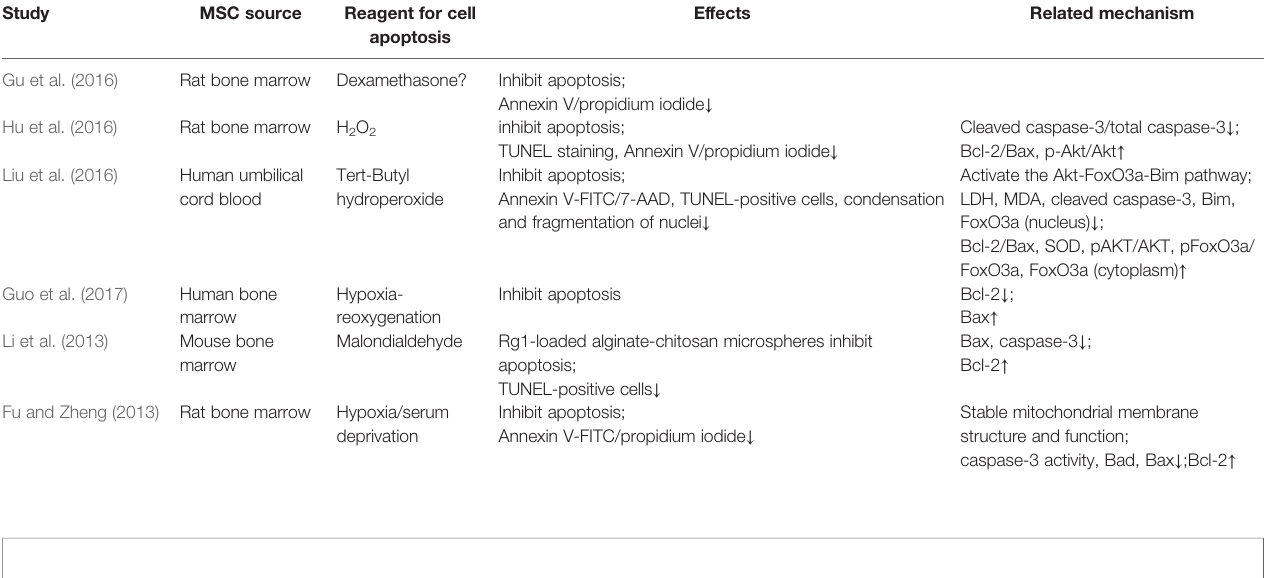
TABLE 3 | Ginsenoside Rg1 inhibits MSC apoptosis in vitro .